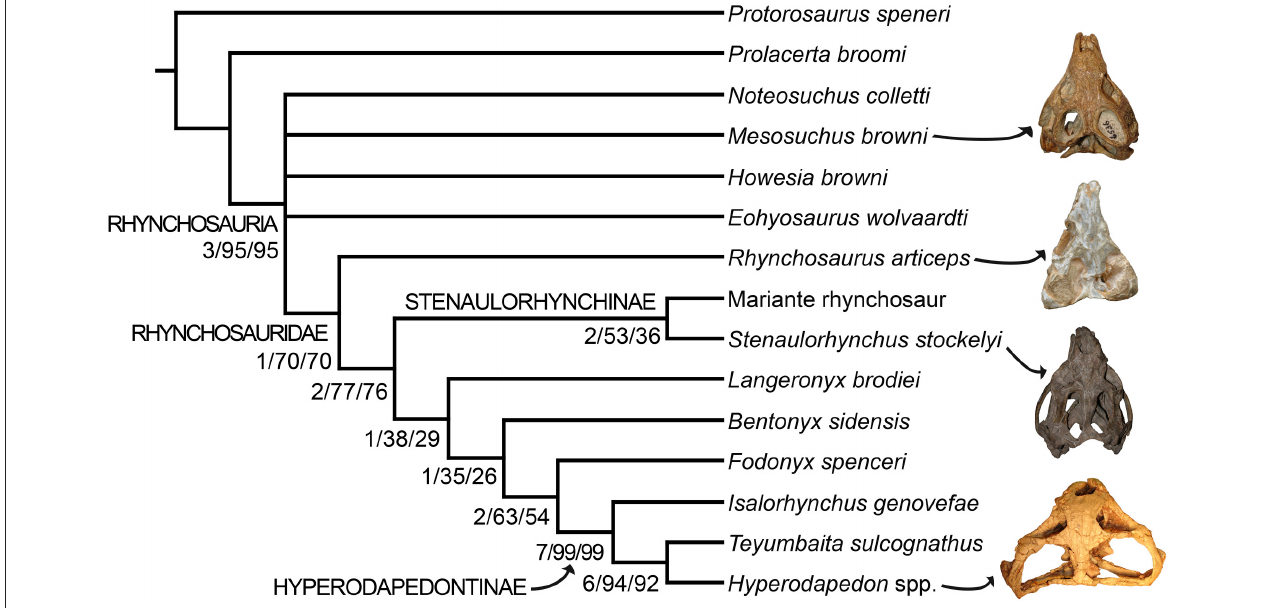
FIGURE 9 | Strict consensus tree showing the phylogenetic relationships of rhynchosaurs recovered here. Numbers below the nodes are Bremer support, absolute bootstrap and GC bootstrap resampling frequencies, respectively. The skulls figured to the right of the cladogram belong to, from the top to bottom, Mesosuchus browni (SAM-PK-6536), Rhynchosaurus articeps (NHMUK PV R1236), Stenaulorhynchus stockleyi (GPIT/RE/7192), and Hyperodapedon mariensis (MCZ